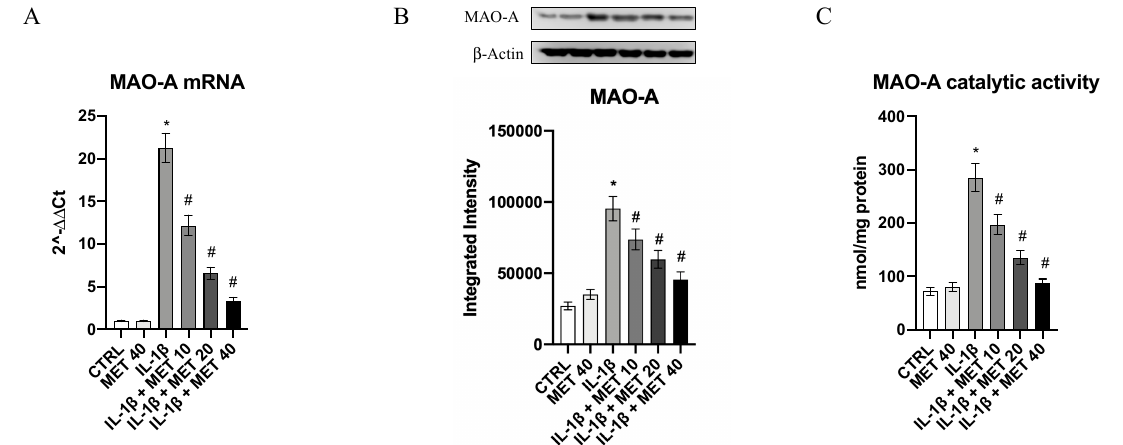
Figure 4. Effects of metaxalone on MAO-A mRNA expression ( A ), MAO-A protein levels ( B ), MAO-A activity ( C ). Values are expressed as the means ± SD. *, p < 0.0001 vs. CTRL; #, p < 0.0001 vs. IL1 β .